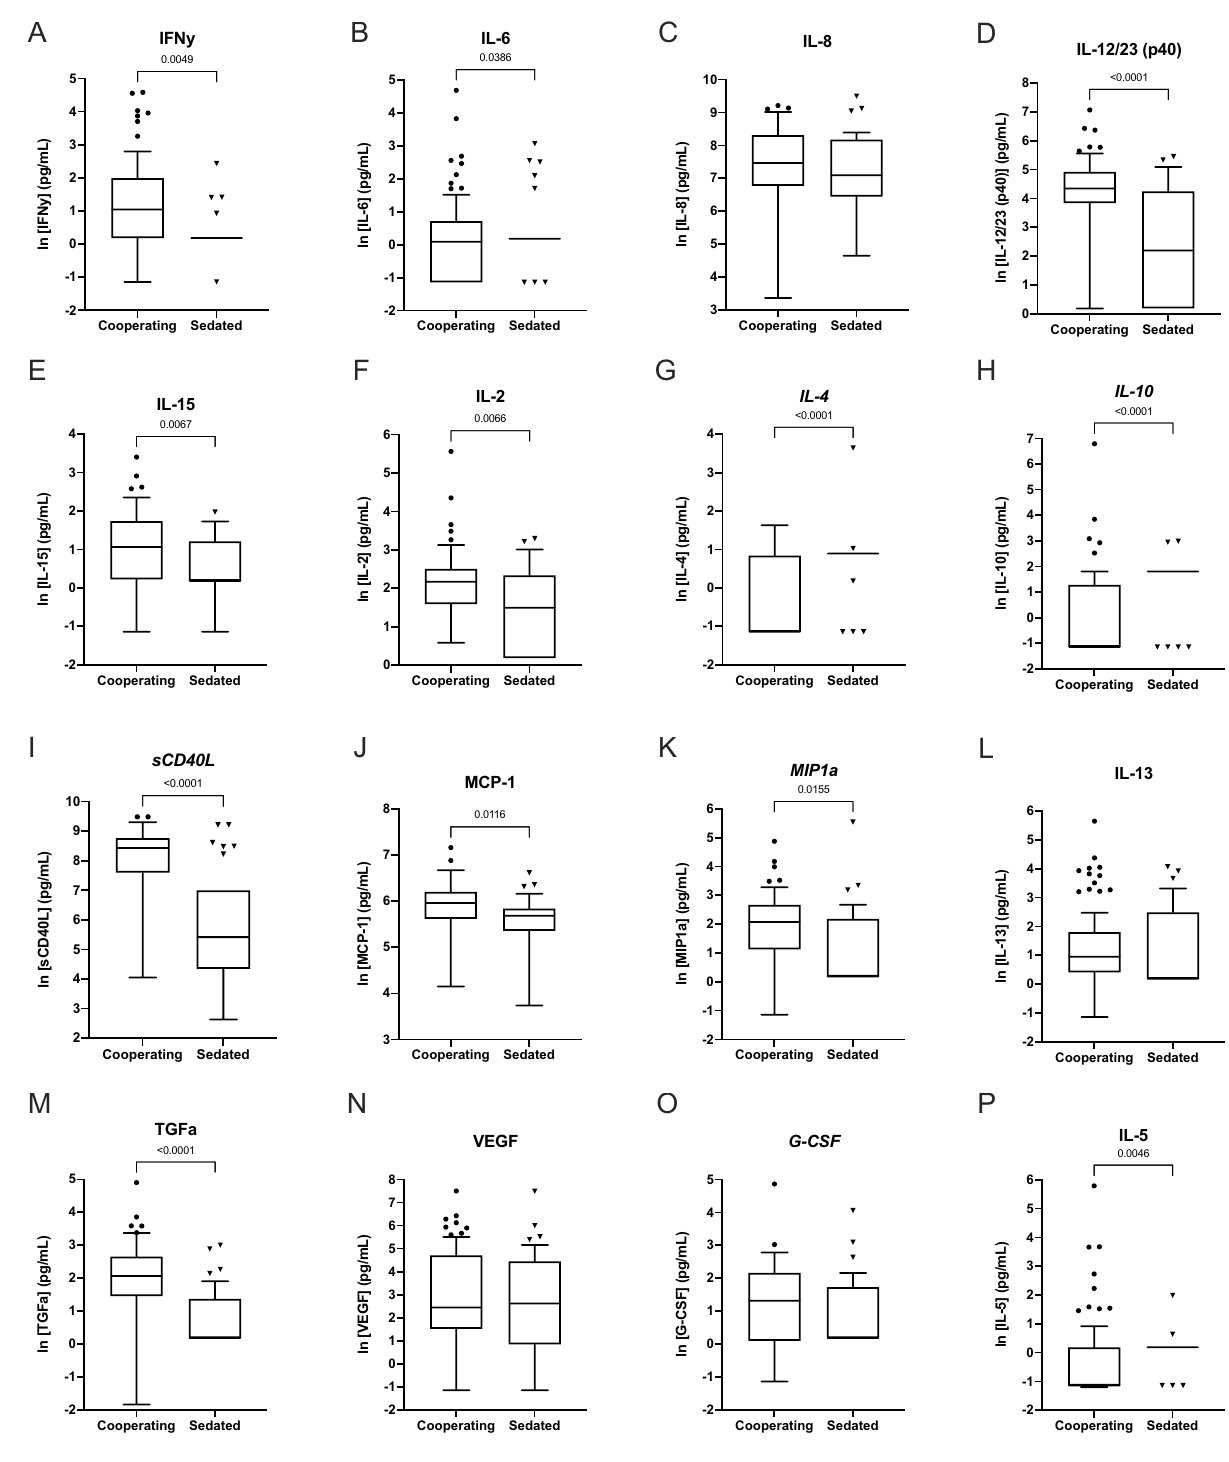
Figure 3. Cytokine detection in cooperating and sedated cynomolgus macaques. Box-plots of serum cytokine detection (pg/mL) in cooperating and sedated cynomolgus macaques. Whiskers on box-plots were calculated using the Tukey method. P-values representing significant group differences were calculated based on non- parametric, unpaired two-way Mann–Whitney tests. Regular title = accept; italicized title =